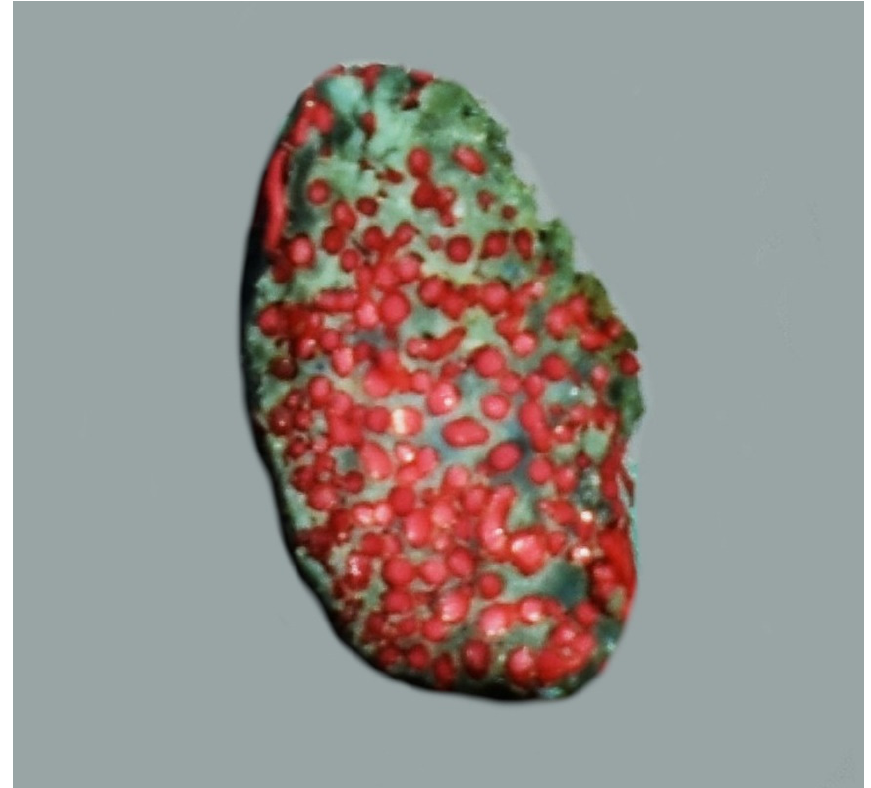
Figure 3. The cross-sectional view of the rostral epidural rete mirabile in the desert warthogs ( Phacochoerus aethiopicus ). A latex cast. Red—arteries of the rete mirabile; blue—cavernous sinus. Veins at the base of the brain are expressed in the form of venous sinuses. The